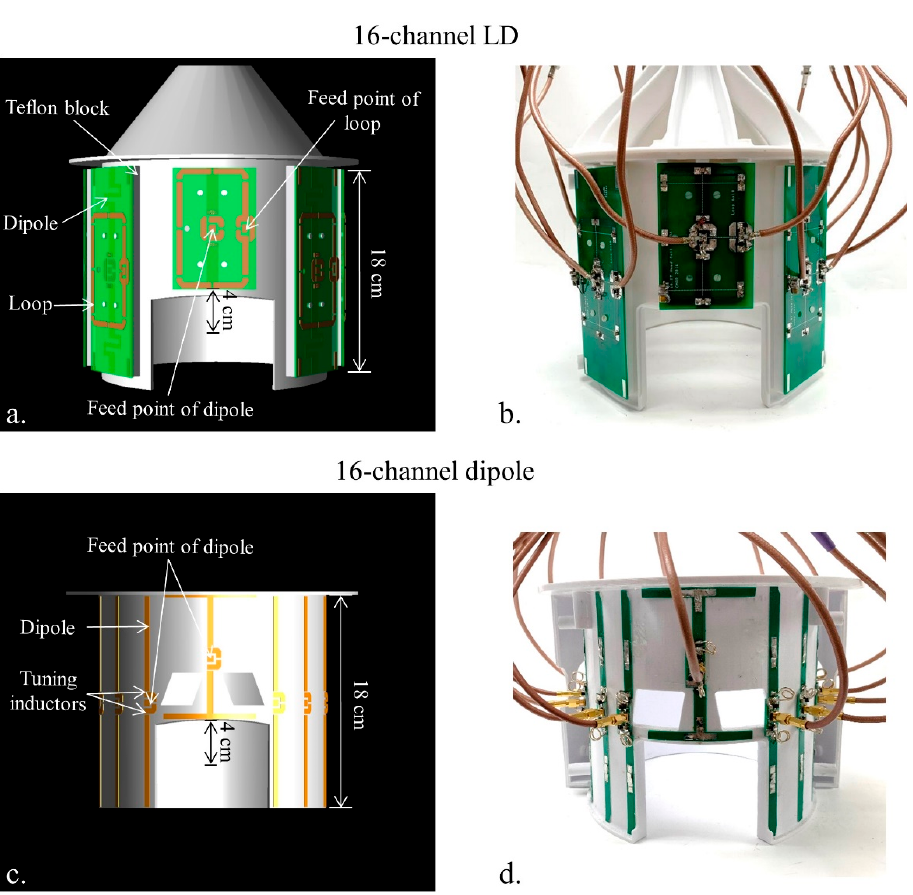
Figure 4. 3D modeling ( a , c ) and photographs ( b , d ) of the built 16-channel LD and dipole antenna arrays. The anterior element of the LD array and dipole antenna array were shifted 4 cm superior. Table 1. Measured S-parameters of the 16-channel LD and dipole antenna arrays. S 11 is the reflection coefficient of each channel, and the S 21 and S 31 are the coupling coefficients between adjacent elements and elements separated by an element between them (second nearest),